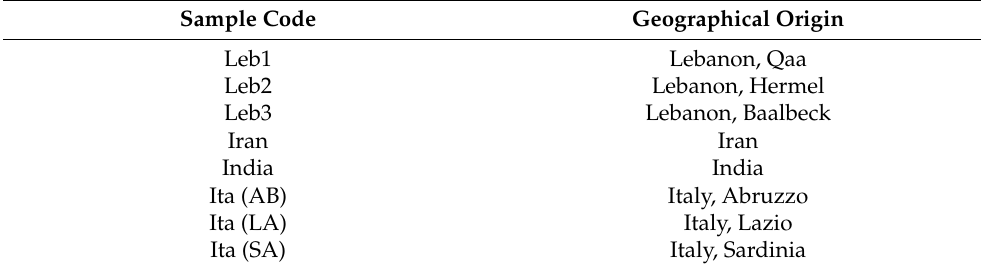
Table 3. Saffron samples analyzed by